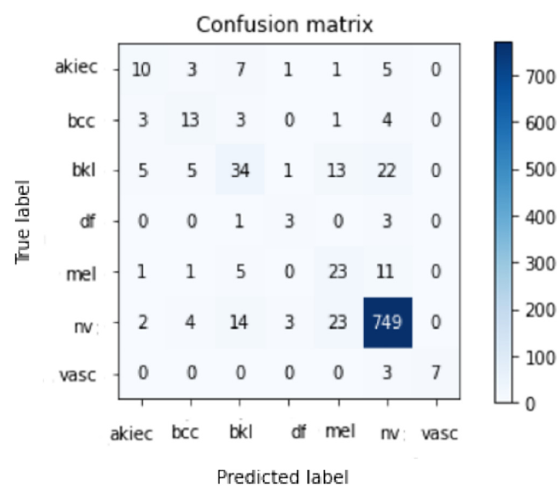
Figure 12. Best confusion matrix of Resnet-50.